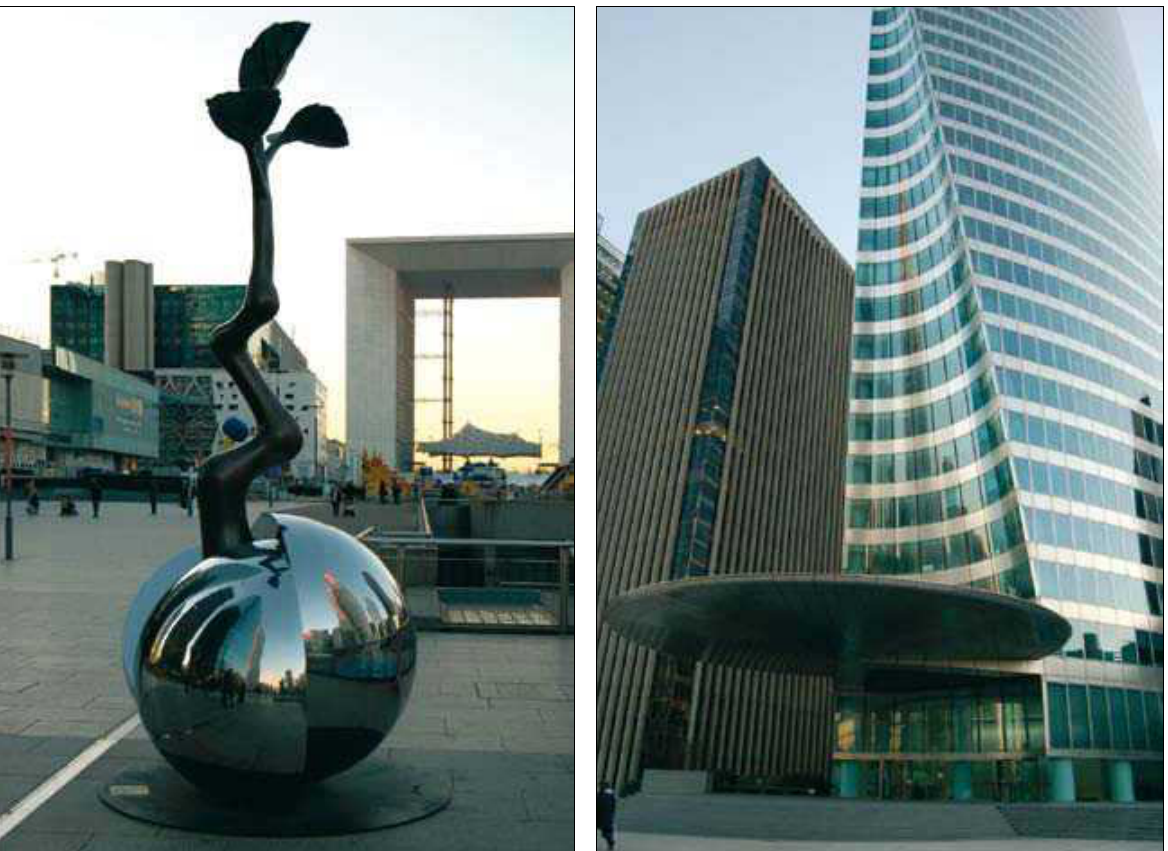
Fig. 3. High-tech style of architecture in Paris ( La Defanse ) (author’s